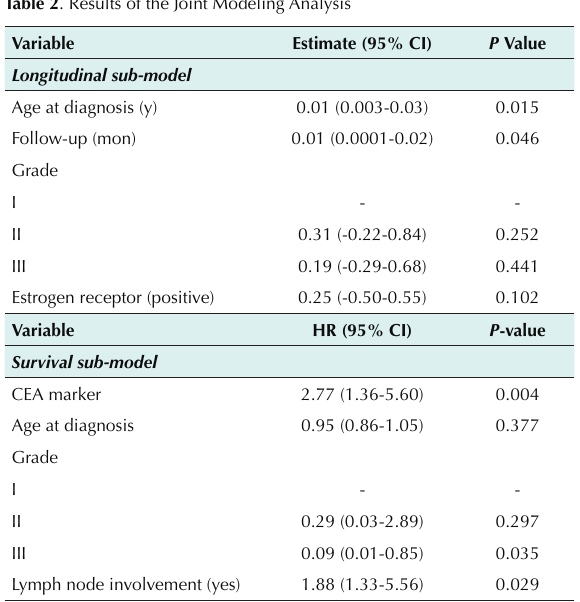
Table 2 . Results of the Joint Modeling Analysis